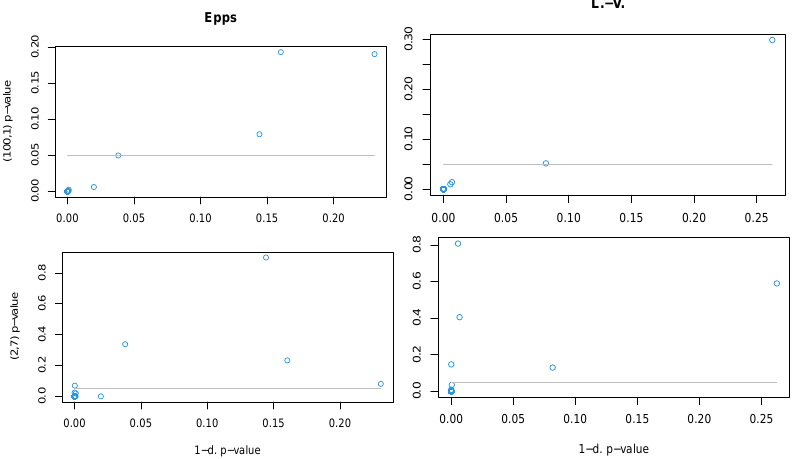
Figure 4. For each of the 63 studied time series, in each of the panels, the p -value is plotted and obtained by applying a Guassianity test on the time series ( x -axis) against the one resulting on applying the same test but on the corresponding projected time series ( y -axis). The left column makes use of the Epps test and the right of the Lobato and Velasco test. For the projection, top row makes use of the parameters (100,1) and the bottom row of (2,7). The line y = 0.05 is displayed in each panel in gray. Table 7. Gaussianity tests for the one-dimensional marginal of the height of sea waves. For each studied buoys (first and fifth columns), it is reported the p -values resulting from applying the Epps (second and sixth columns) and the Lobato and Velasco test (third and seventh columns) and adjusted p -values using the false discovery rate (FDR) for dependent tests (fourth and eighth columns). The bold indicates that the values are larger than